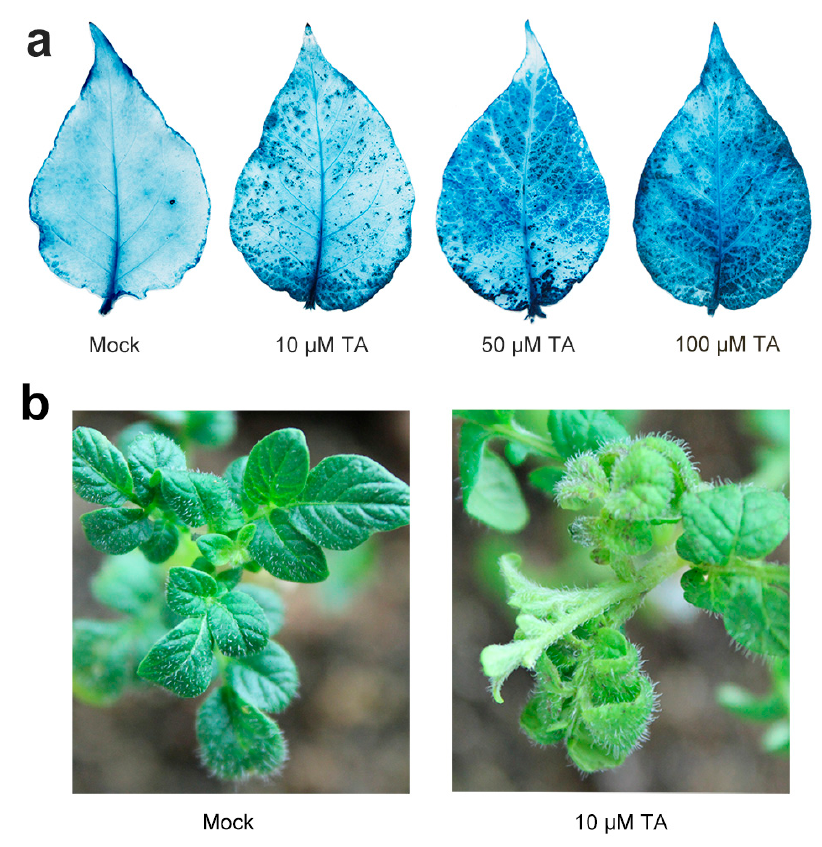
Figure 1. Effects of thaxtomin A (TA) treatment on potato leaves. ( a ) Potato leaves treated with different concentrations of TA for 24 h and stained with trypan blue. The experiments were repeated three times, and similar results were obtained. ( b ) Phenotypes of potato plants treated with sterile water and 10 µ M TA for 24 h. All experiments were performed in triplicate with similar results.